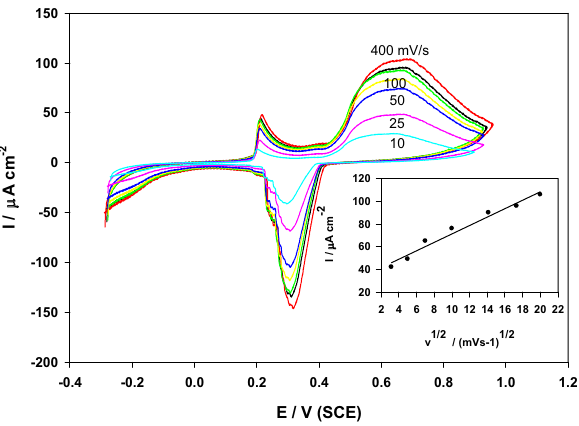
Figure 6. Effect of varying the scan rate from (10–400 mVs -1 ) on the anodic peak current of SMWZCPE in 0.5 M H 2 SO 4 . Inset: the plot of the anodic peak current and the square root of scan rate.